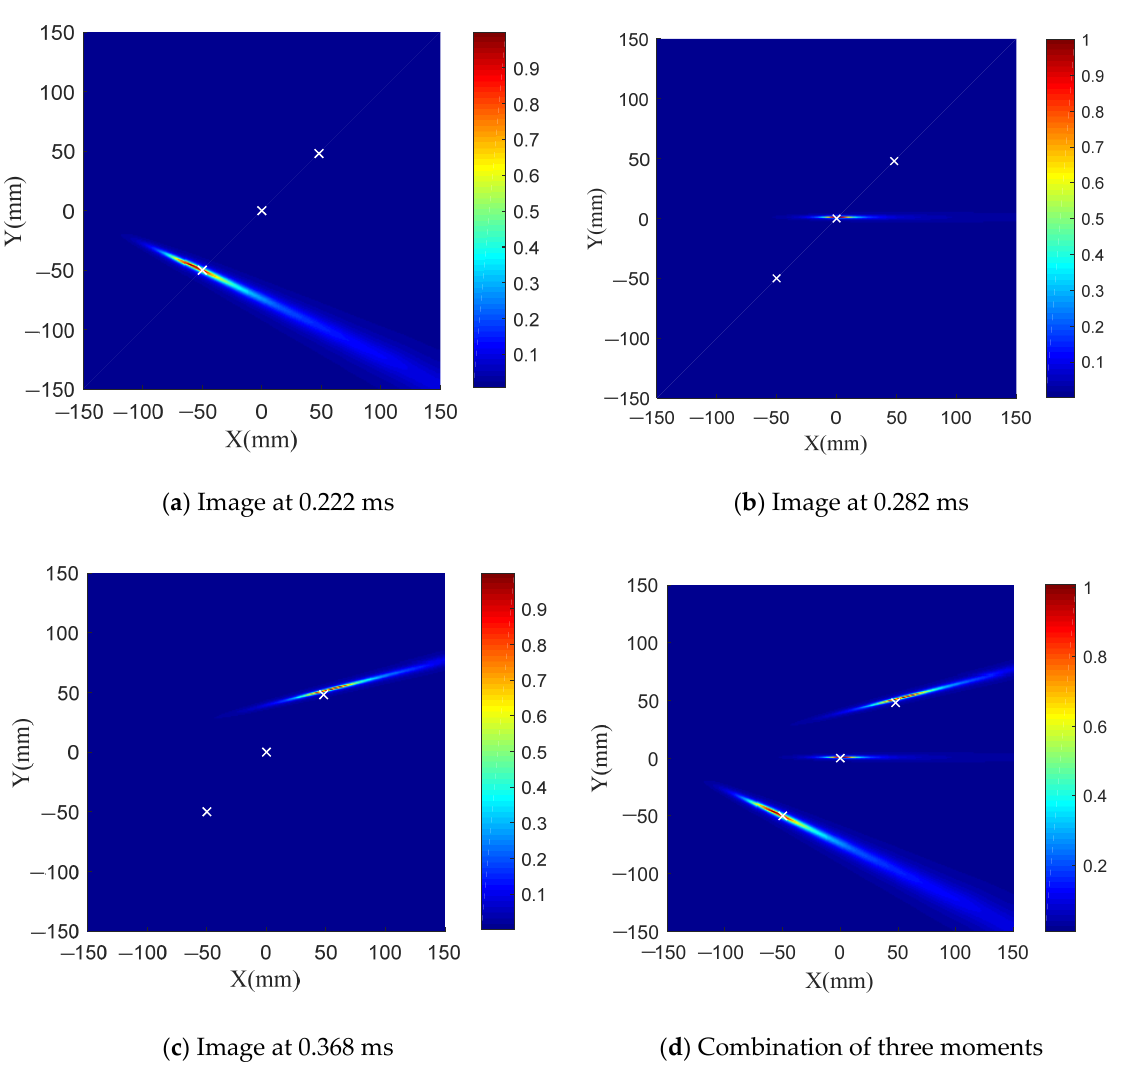
Figure 11. Damage imaging by using local TR ‐ MUSIC algorithm.